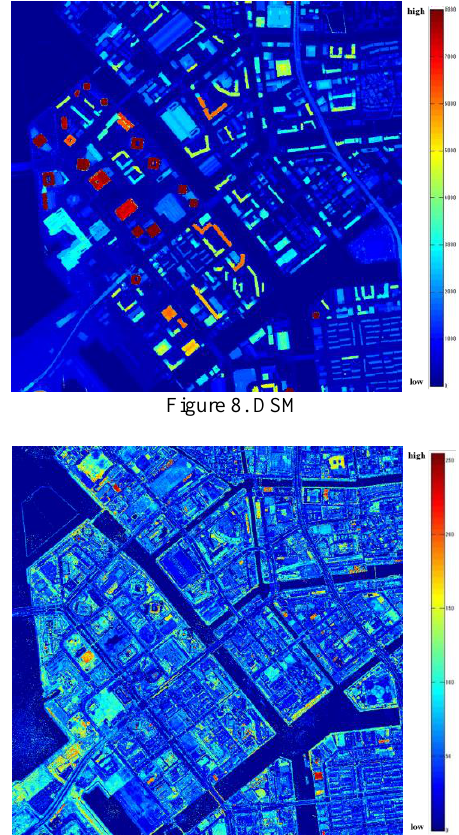
Figure 9. Reflection intensity orthoimage